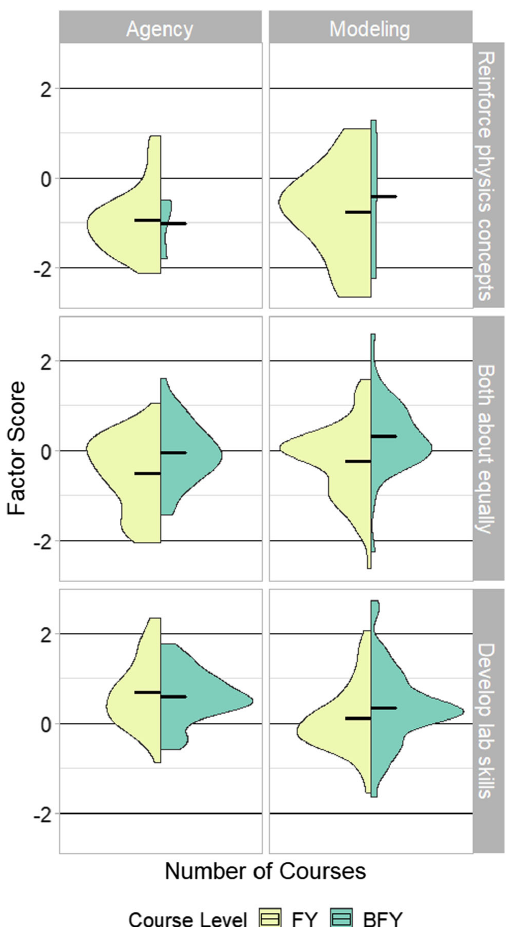
FIG. 2. Number of weeks spent in FY- and BFY-level courses